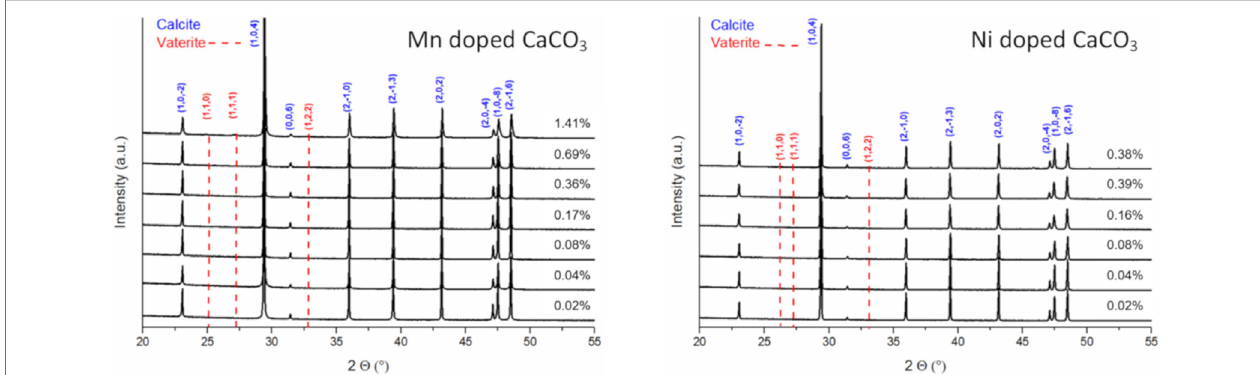
FIGURE 2 | XRD patterns of precipitated and dried Mn (left) and Ni (right) doped CaCO 3 aged for 1 day.